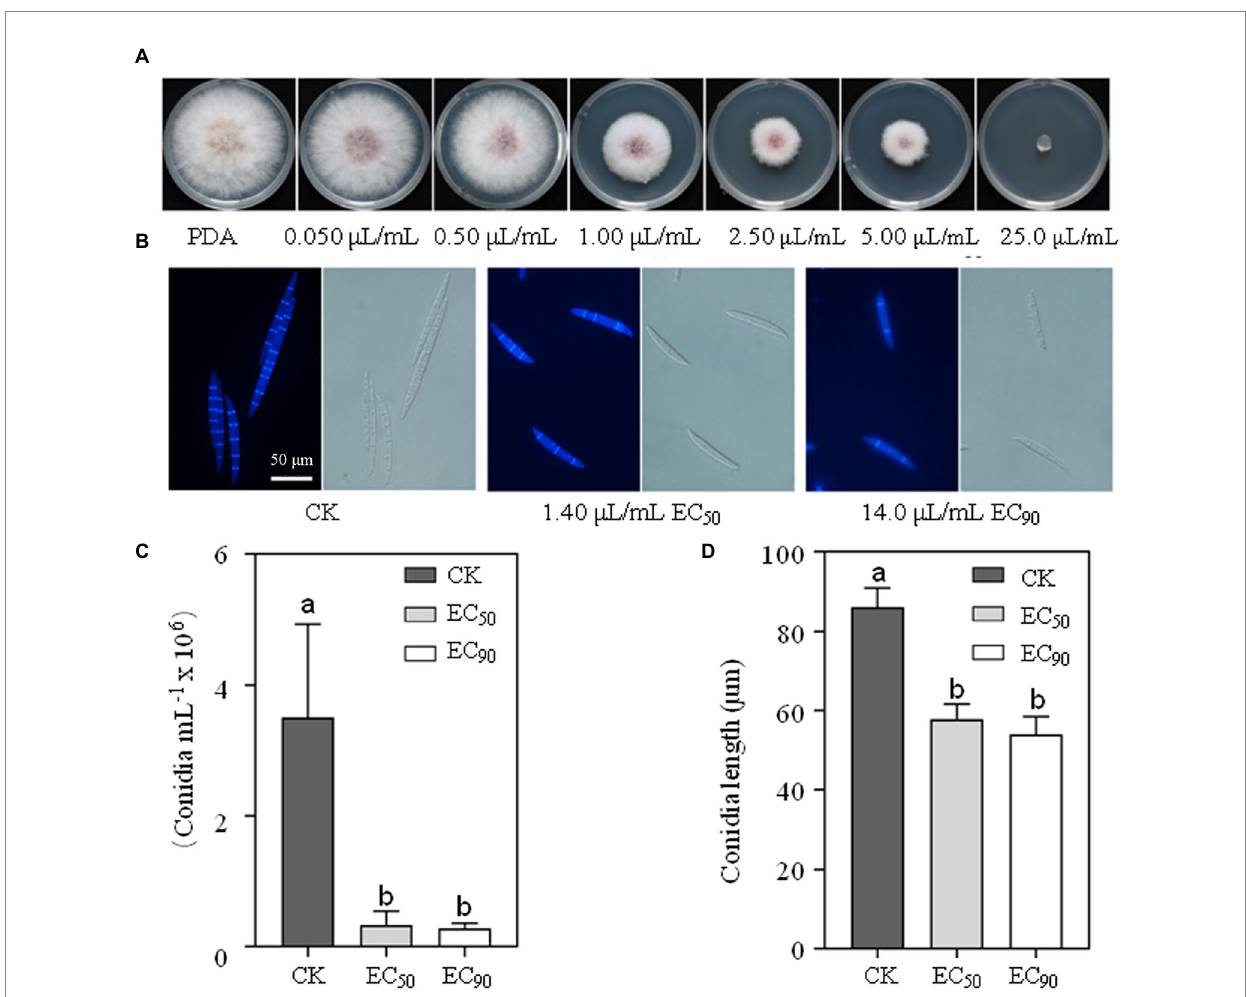
FIGURE 1 Limonene formulation inhibited the mycelial growth and conidia production of Fusarium graminearum. (A) Limonene formulation with different concentrations inhibited the mycelial growth of PH-1. (B) Limonene formulation caused change in conidial morphology and quantity of PH-1. (C) Limonene formulation decreased the numbers of conidia. (D) The length of the conidia was reduced by limonene formulation. Line bars in each column denote SE of three repeated experiments. Values on the bars followed by the same letter are not significantly different at p =